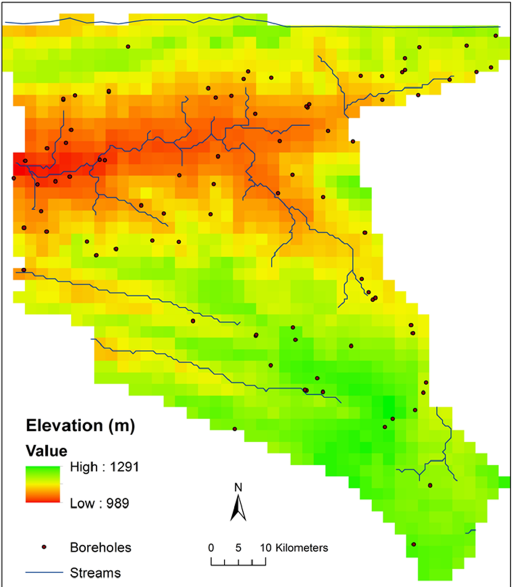
Figure 5. Digital elevation map (2 km grid resolution) for the Nkayi district. The grid was resampled from the worldwide SRTM 90 m elevation grid [35].